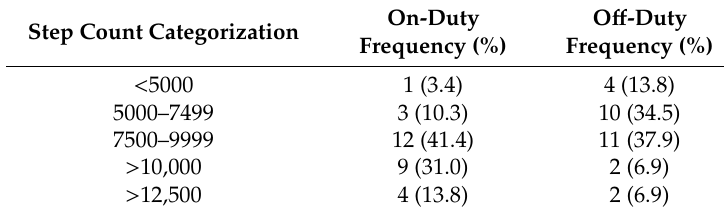
Table 2. Step count categorization frequency.